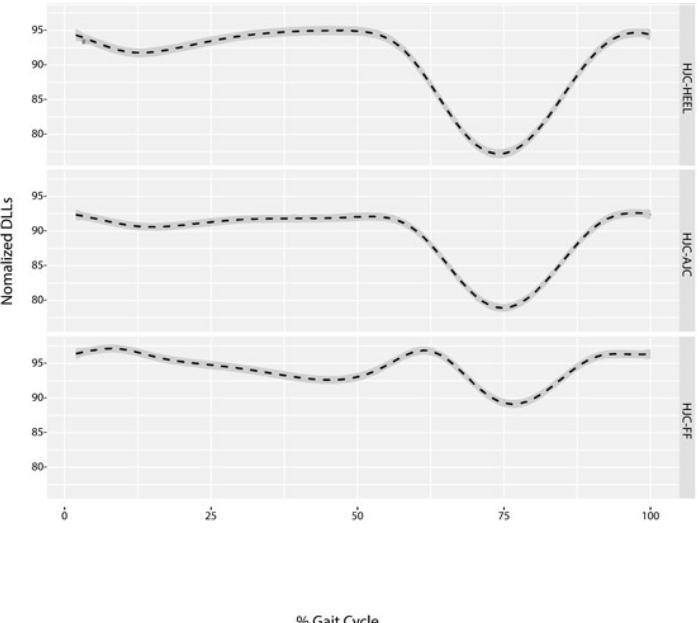
Figure 7. Normalized DLLs to leg length. Mean value (dotted line) ± standard deviation (grey area).